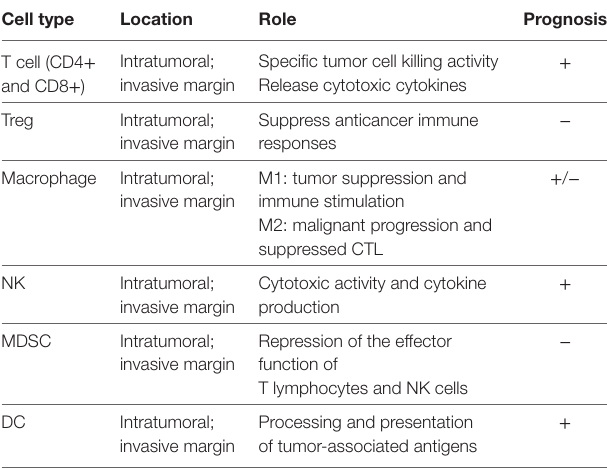
TabLe 2 | Immune intrigue of colorectal liver metastases